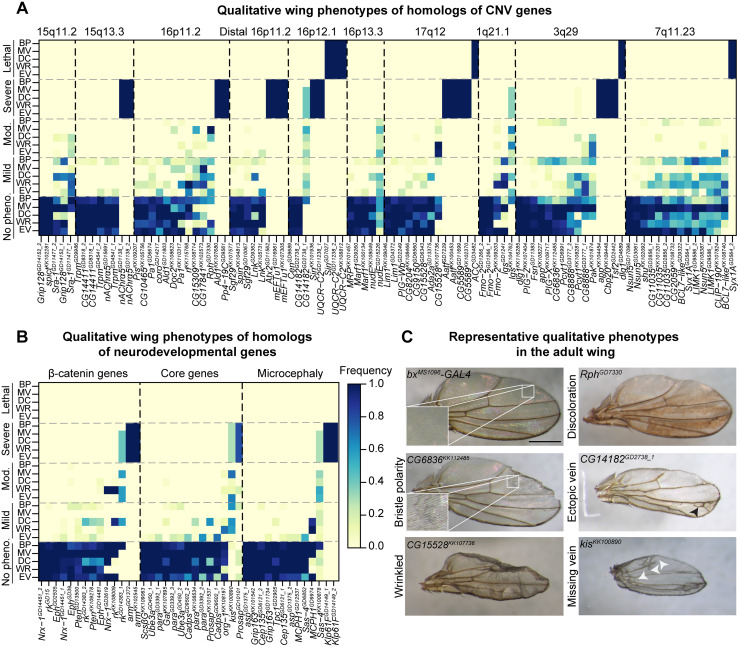
Qualitative adult wing phenotypes of Drosophila homologs of CNV and neurodevelopmental genes.Heatmaps representing five qualitative adult wing phenotypes for all 136 RNAi lines, with (A) 59 tested homologs for 10 CNV regions and (B) 20 homologs for neurodevelopmental genes (β-catenin, core neurodevelopmental genes, and microcephaly genes), are shown. The color of each cell represents the frequency of each qualitative phenotype by severity (wrinkled wings, WR; ectopic veins, EV; missing veins, MV; discoloration, DC; bristle planar polarity, BP), ranging from no phenotype to lethal. (C) Representative brightfield images of adult fly wings (scale bar = 500μm) with wing-specific knockdown of homologs of CNV and neurodevelopmental genes show the five assessed qualitative phenotypes. Panels in the bxMS1096-GAL4 control and CG6836KK112485 images highlight bristle planar polarity phenotypes for the representative images. Black arrowheads highlight ectopic veins, and white arrowheads highlight missing veins. Genotypes for the images are: w1118/bxMS1096-GAL4;+; UAS-Dicer2/+, w1118/bxMS1096-GAL4;UAS-RphGD7330
RNAi/+;UAS-Dicer2/+, w1118/bxMS1096-GAL4;UAS-CG15528KK107736
RNAi/+; UAS-Dicer2/+, w1118/bxMS1096-GAL4;UAS-CG6836KK112485
RNAi/+; UAS-Dicer2/+, w1118/bxMS1096-GAL4;+;UAS-CG14182GD2738
RNAi/UAS-Dicer2, and w1118/bxMS1096-GAL4;UAS-kisKK100890
RNAi/+; UAS-Dicer2/+.